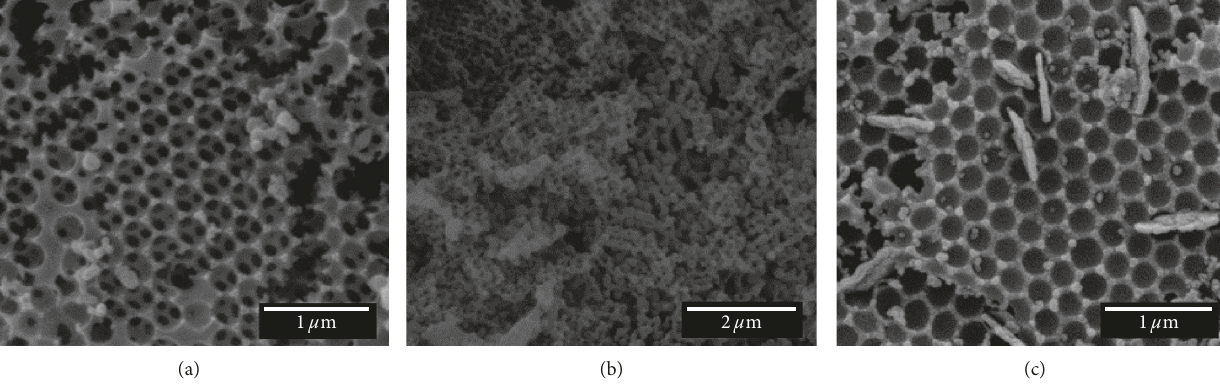
° C ( × 40000) and (b) at 800 ° C ( × 20000) and (c) 3DOM Ca 2 O 3 (a) at 700